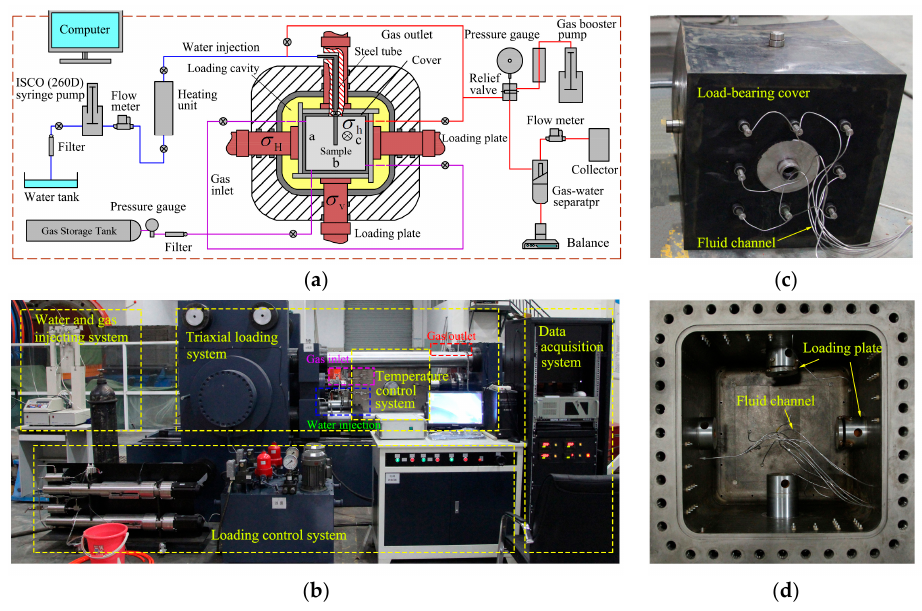
Figure 3. ( a ) Diagram showing the components that make up the large-scale true-triaxial hydraulic fracturing test apparatus; ( b ) Photograph of the apparatus shown in ( a ); ( c ) Load-bearing cover that seals the test apparatus sample carrier; ( d ) The triaxial test apparatus loading cavity.